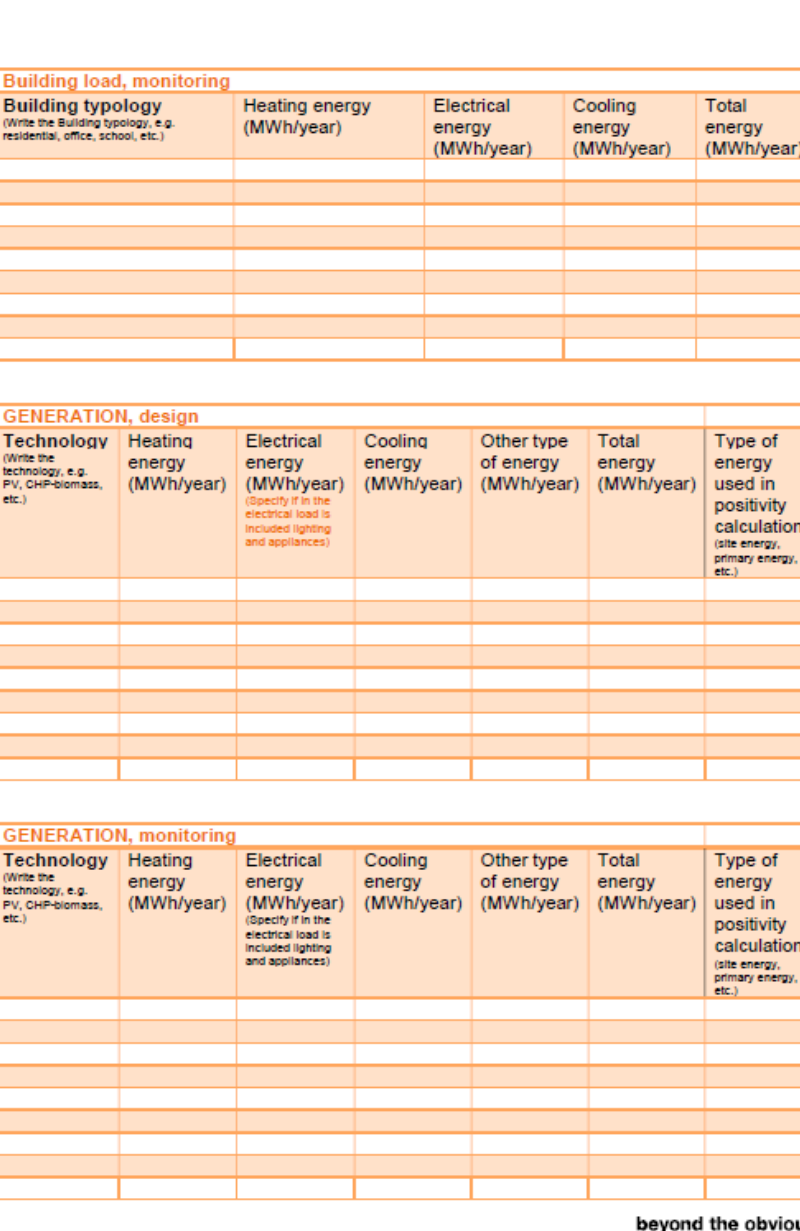
Figure A4. Copy of the fourth page of the questionnaire produced to conduct this study.